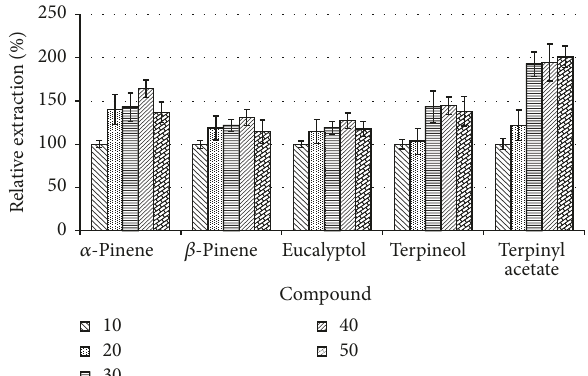
Figure 4: The effect of varying extraction time of volatiles of A.